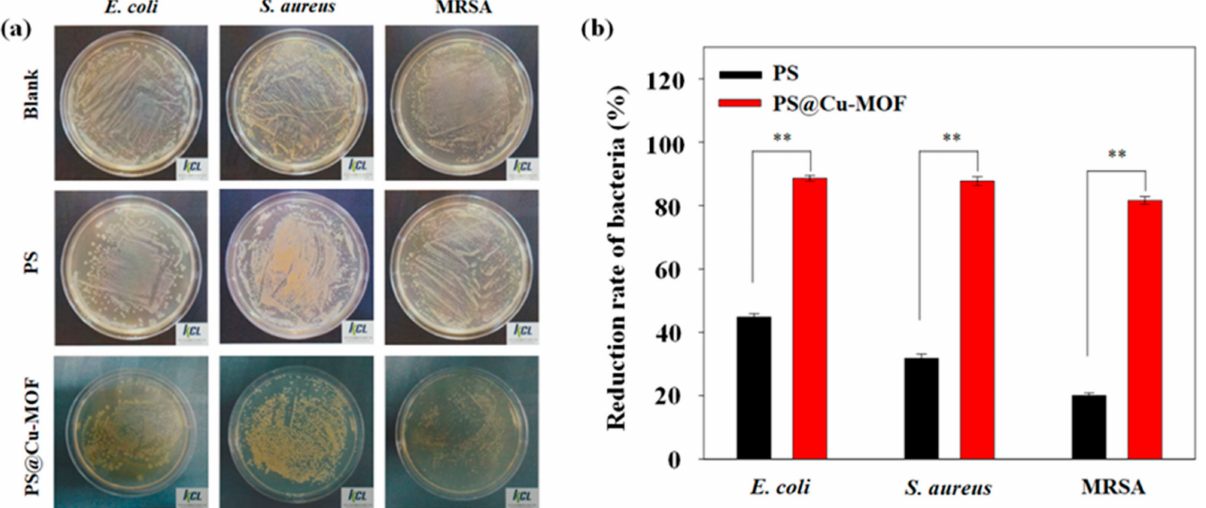
Figure 5. ( a ) Representative images of bacteria grown on PS and PS@Cu-MOF after incubation for 24 h: Top (blank), middle (PS), and bottom (PS@Cu-MOF); left to right: E. coli , S. aureus , and MRSA. ( b ) The antibacterial efficiency of PS and PS@Cu-MOF towards E. coli , S. aureus , and MRSA (means ± standard deviation with n = 3; **: p < 0.01). Table 1. Antibacterial activity of the MOF-embedded PS against various bacteria. Test